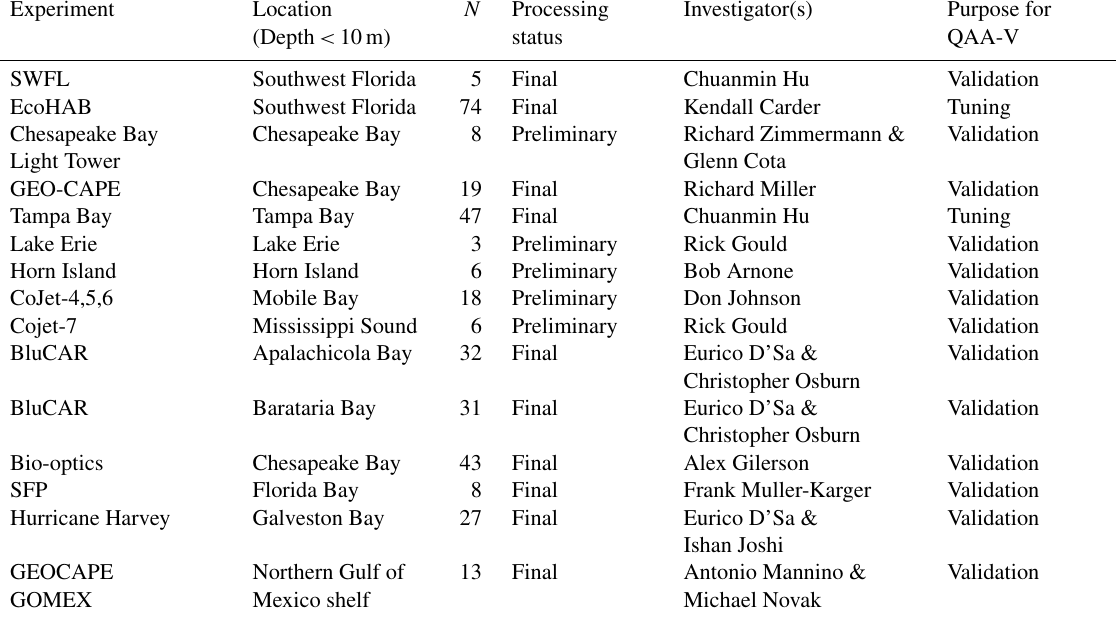
Table 1. In situ estuarine and nearshore dataset (IES: IOPs and R rs matchups) compiled from the SeaBASS with locations, possessing status, project instructors, and the purpose in this analysis. Apalachicola Bay, Barataria Bay, and Galveston Bay datasets were collected by the authors during various field